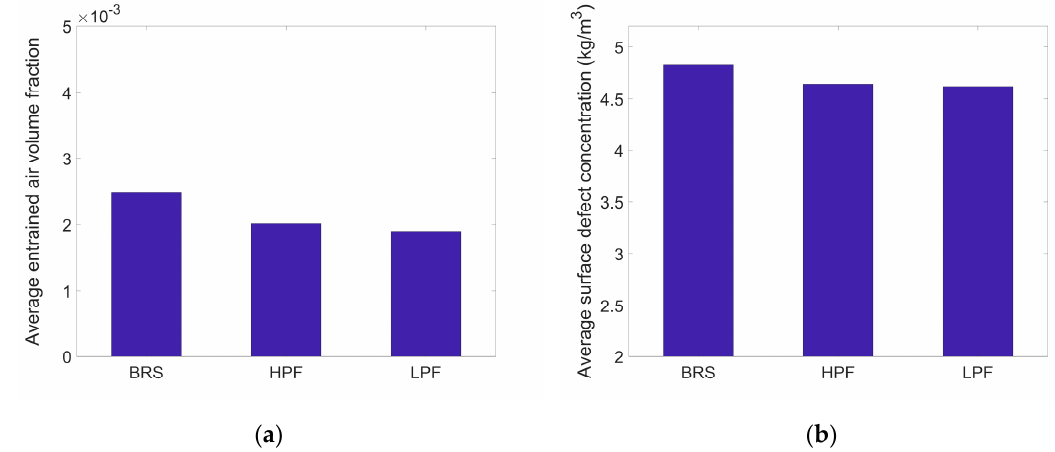
Figure 7. ( a ) Average entrained air volume fraction and ( b ) average surface defect concentration for the basic running system (BRS), high placed filter (HPF) and low placed filter (LPF) designs.